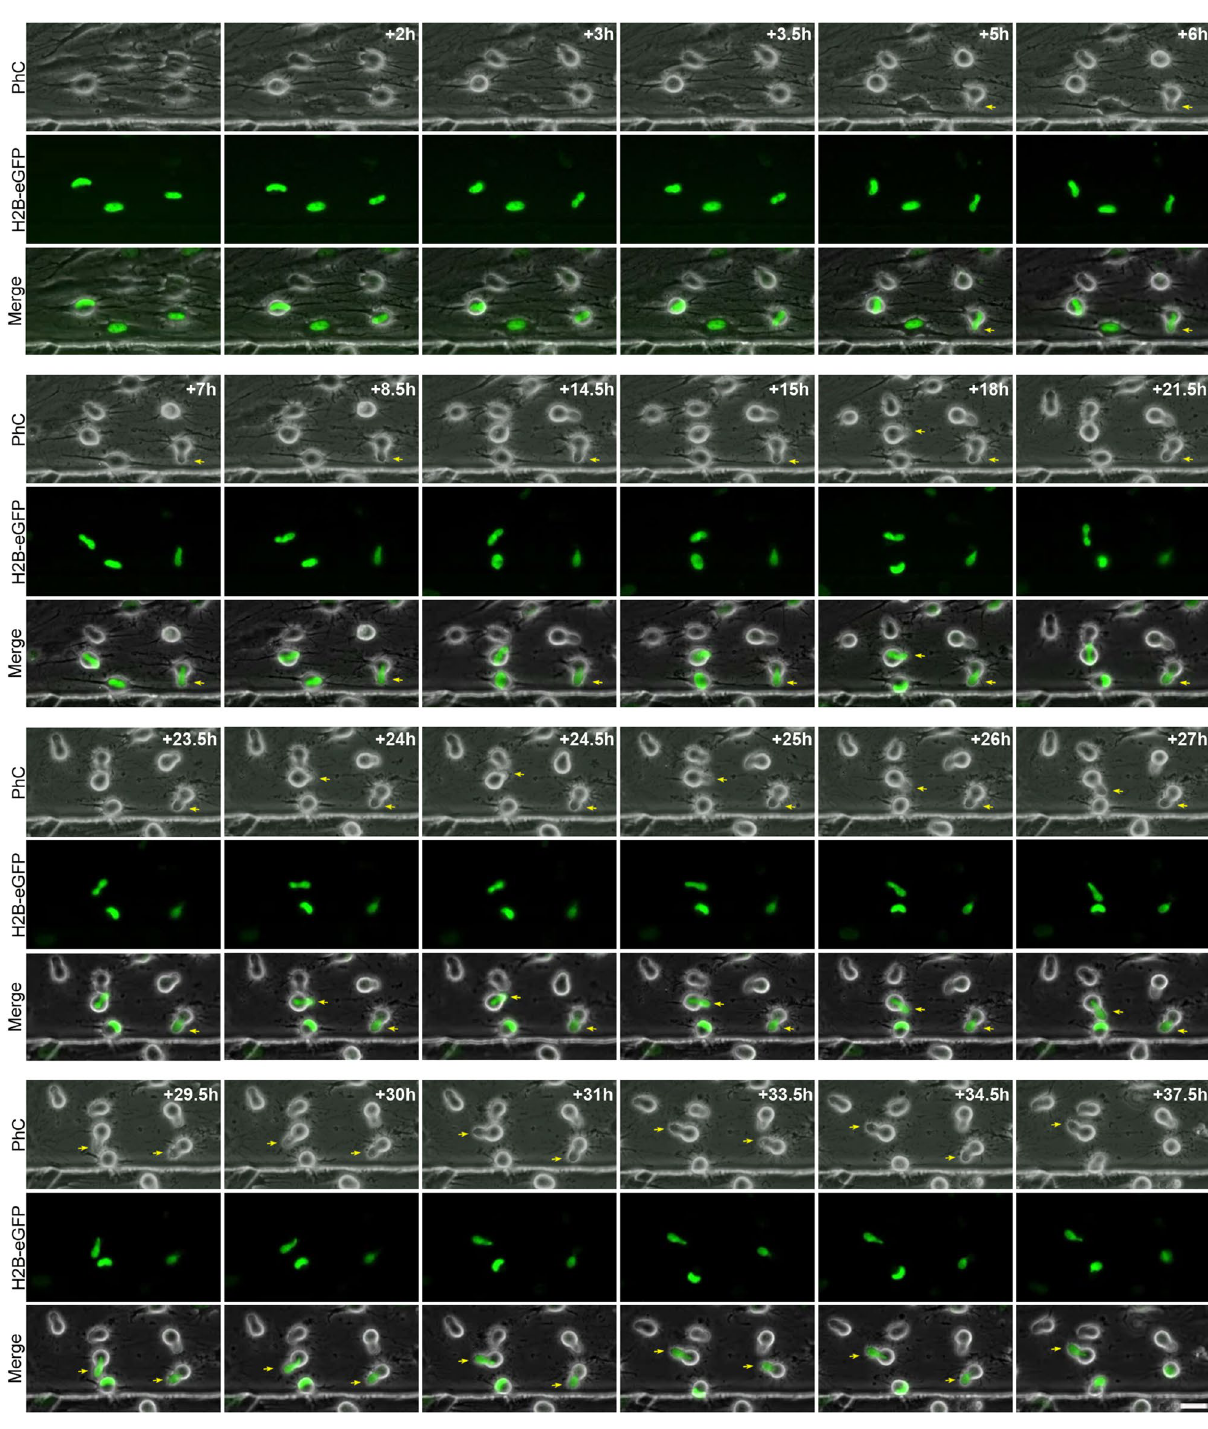
Figure 5. Nuclear movement generated cellular protrusions that appeared and disappeared from the surface of hBM-MSC-derived intermediate cells. Time-lapse microscopy revealed that the cell nucleus of histone H2B- GFP-expressing hBM-MSCs acquired a finger-like shape and moved within the cell, generating the transient cellular protrusions (arrows) on the surface of the hBM-MSC-derived intermediate cells. Scale bar: 25 µm. PhC Phase-contrast